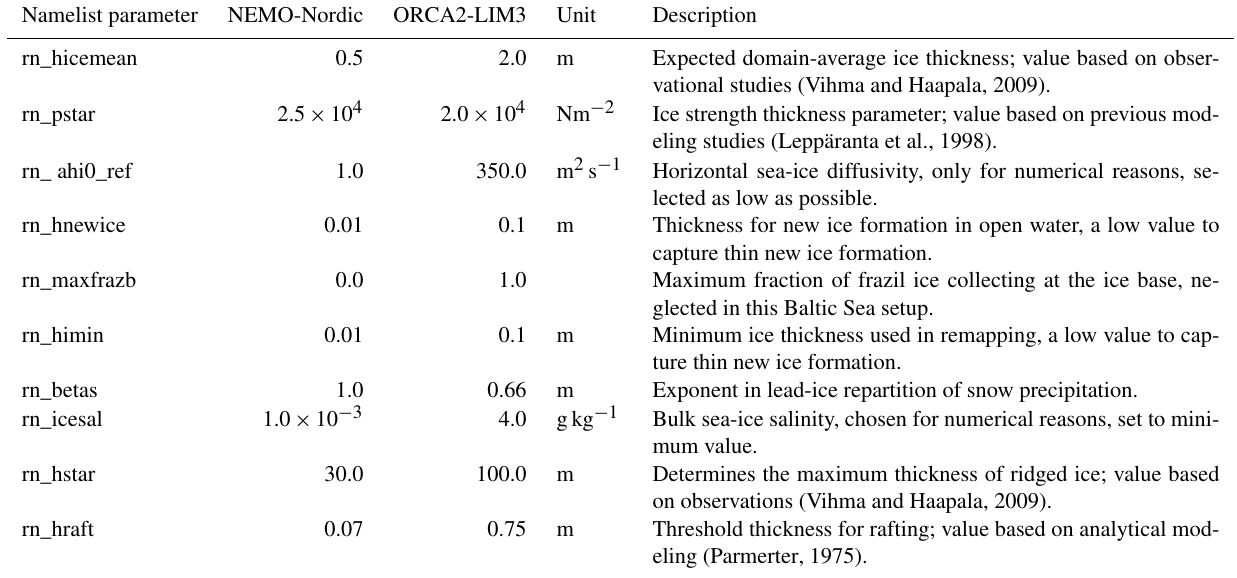
Table 1. Physical parameters in the sea-ice namelist (namelist_ice_ref) that where changed in NEMO-Nordic compared to the standard global ORCA2-LIM3 that is included in the NEMO–LIM3.6 model